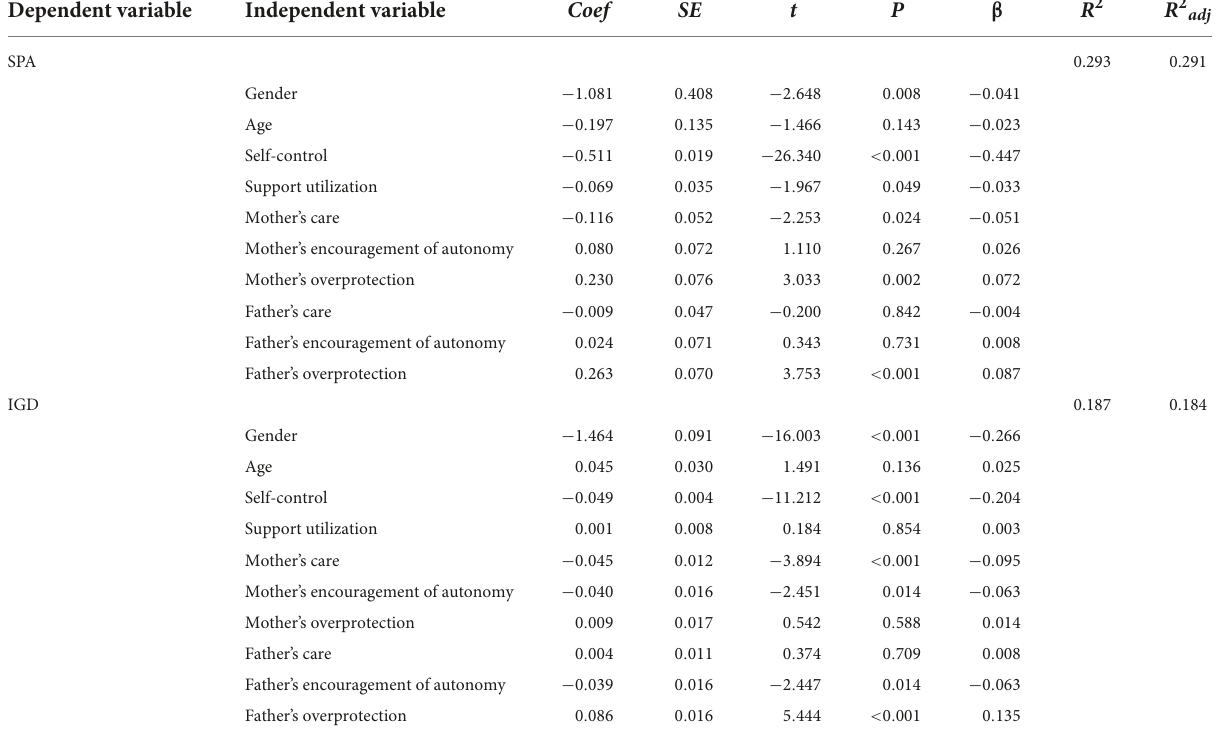
TABLE 6 Multiple regression analysis on SPA and IGD ( n =